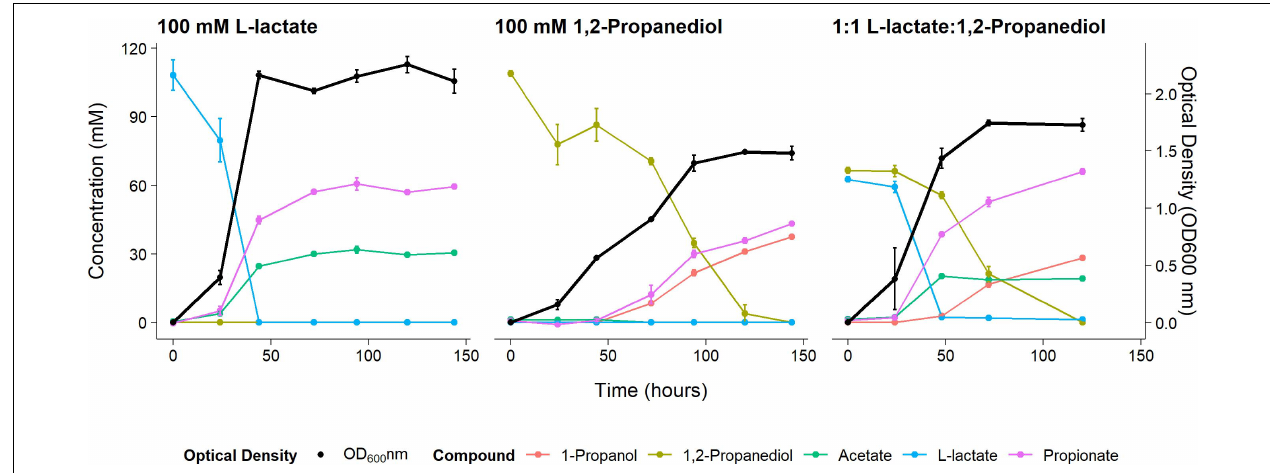
FIGURE 1 | Substrate consumption, metabolite production and biomass formation of P. freudenreichii grown on 100 mM L -lactate, 100 mM 1,2-Propanediol, and 1:1 1,2-Propanediol: L -lactate for 6 days. Error bars = standard error ( n = 3 biological replicates).